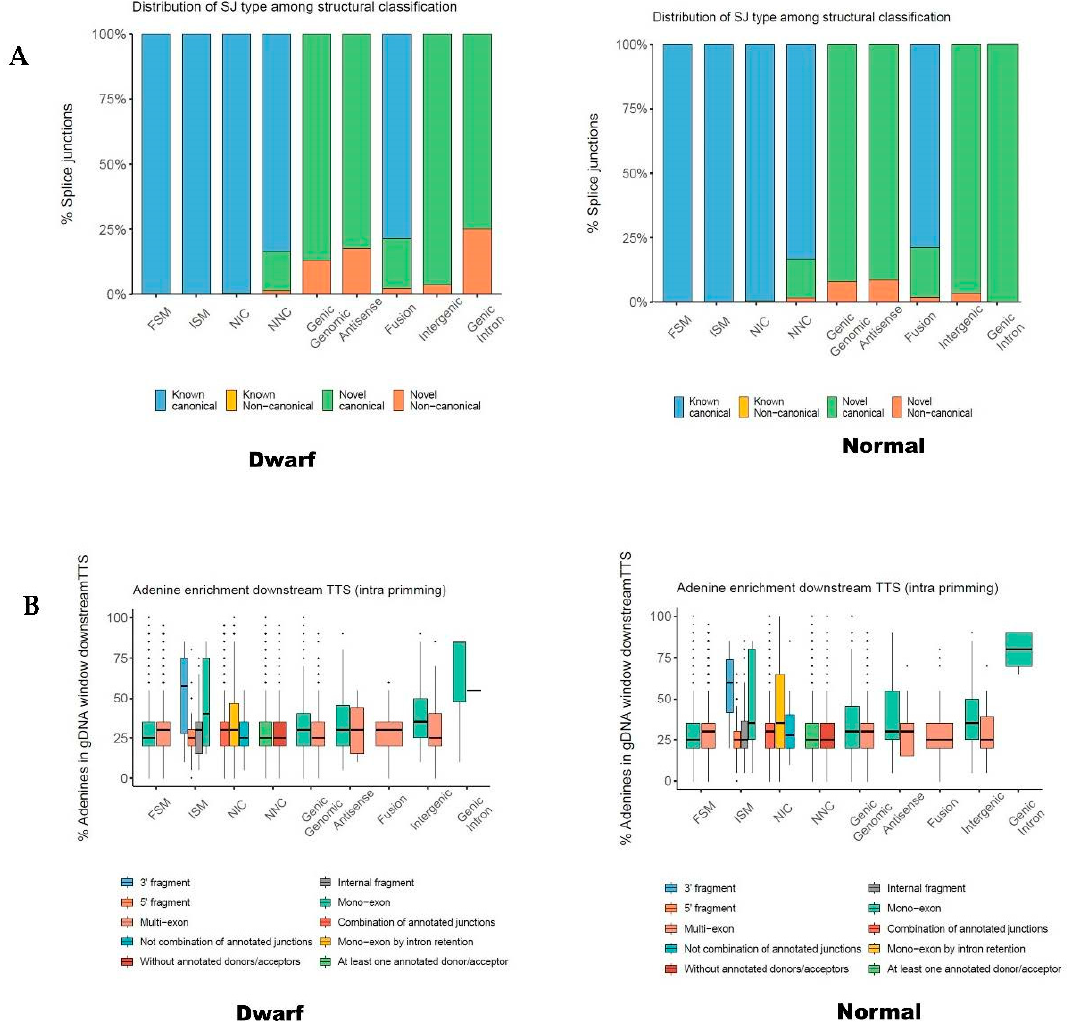
Figure 5. ( A ) Distribution of splice junction (SJ) types across SQANTI categories. NNC, genic genomic, antisense, fusion, intergenic, and genic intron are enriched in noncanonical SJs. ( B ) Percentage of adenine in the 20 nt window of genomic DNA downstream from TTS. All groups had monoexon and multiexon isoforms except ISM and NIC. NIC consisted of a combination of annotated junctions, mono exon by intron retention, and not combination of annotated junctions. ISM consisted of isoforms formed by 3 ′ fragment, 5 ′ fragment, internal fragment, and monoexons. NNC consisted of two types of isoforms viz. at least one annotated donor/acceptor and combination of annotated. 3.4. Isoform Distribution across Normal and Dwarf Lines We observed that the isoforms in a number of genes demonstrated different numbers in the dwarf and normal lines. We shortlisted such isoforms, and 61 genes showed a dif- ference of 3 or more between dwarf and normal lines (Supplementary Table S5). For ex- ample, the GLYMA_14G209400 gene had 4 isoforms in the dwarf line and 11 isoforms in the normal lines. Moreover, GLYMA_14G092800 had 10 isoforms in the dwarf line and 7 in the normal lines. We observed the dwarf line compared with normal controls. Among the 61 genes, 14 were related to the defense response, with the dwarf type demonstrating the greatest number of isoforms of all the genes (Figure 6). Among the shortlisted